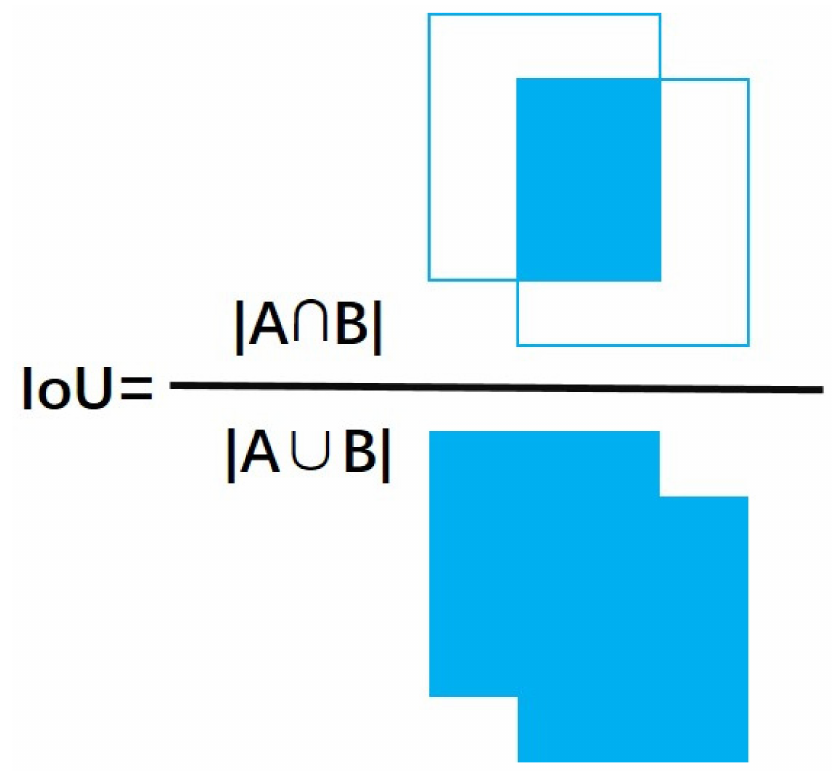
Figure 4. The visual display of IOU